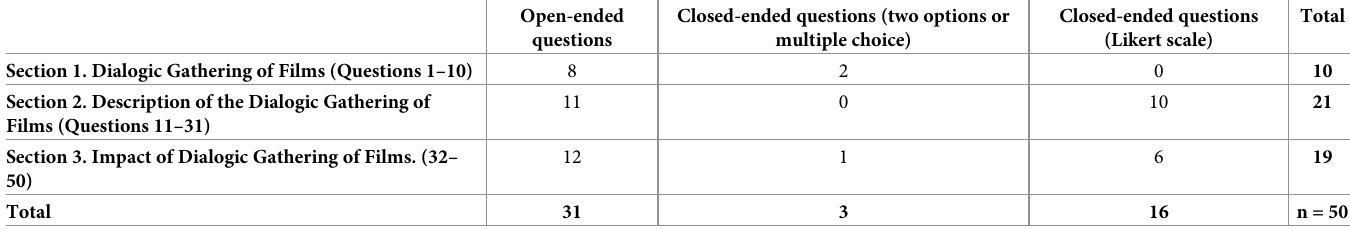
Table 5. Questionnaire